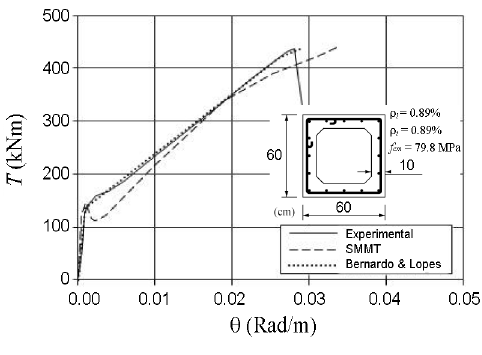
Fig. 10. T – θ curves for Beam A4